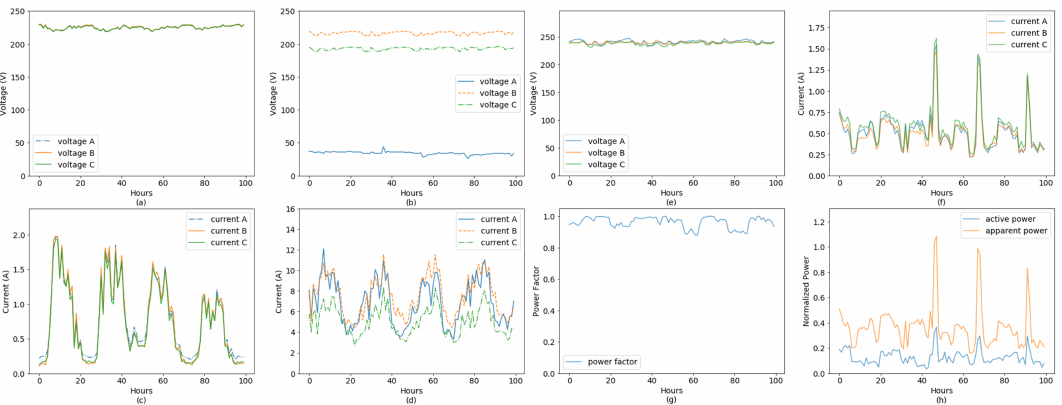
Figure 1. Comparision of normal and Shunts by curves of voltages and currents.